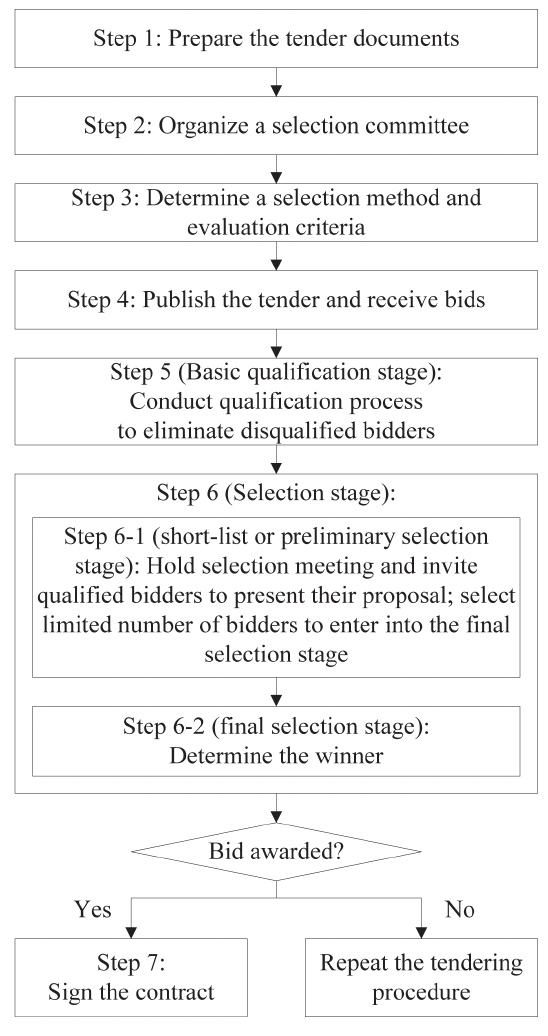
Fig. 1. Procedural steps of the BV